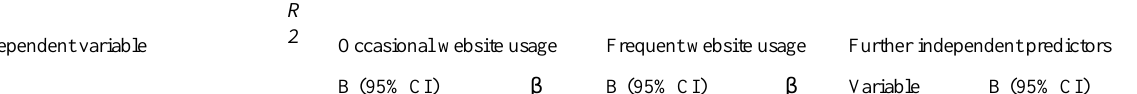
Table 6. Multivariate linear regression—as-treated analysis. Each line starting with a dependent variable contains information from one regression analysis (N=571) and provides model fit ( R 2 ), results for the variables occasional website usage and frequent website usage (regardless of significance), and those variables which were demonstrated to be significant independent predictors in the